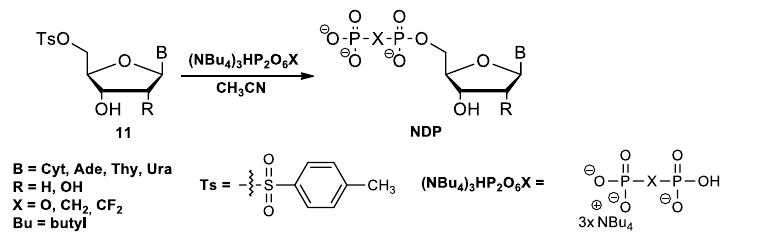
Scheme 8. The Poulter’s method for the synthesis of nucleoside 5′ -diphosphates [67].